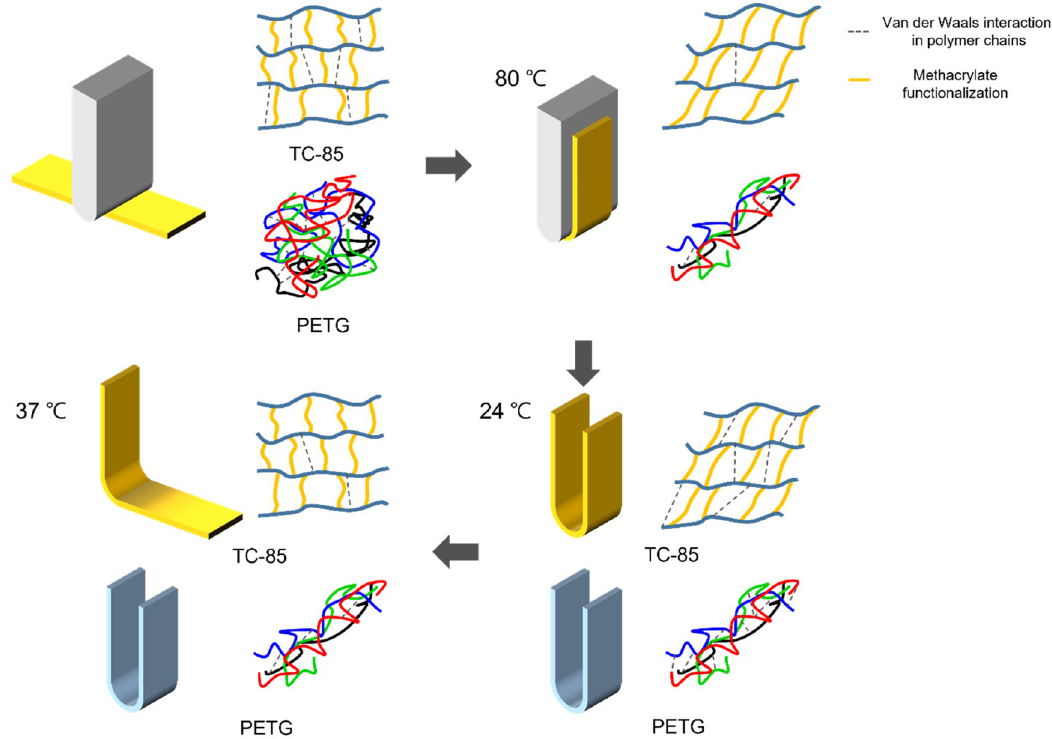
Figure 5. Shape memory property test procedure and shape memory mechanism; Yellow and blue specimens indicate TC-85 and PETG,